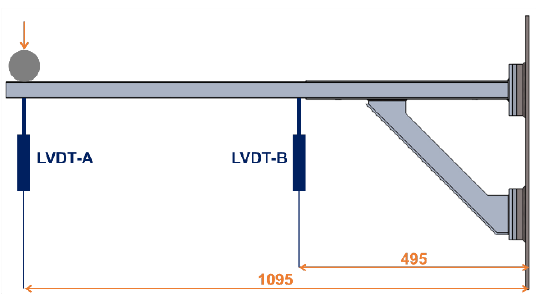
Figure 3. Positions of the LVDT sensors.